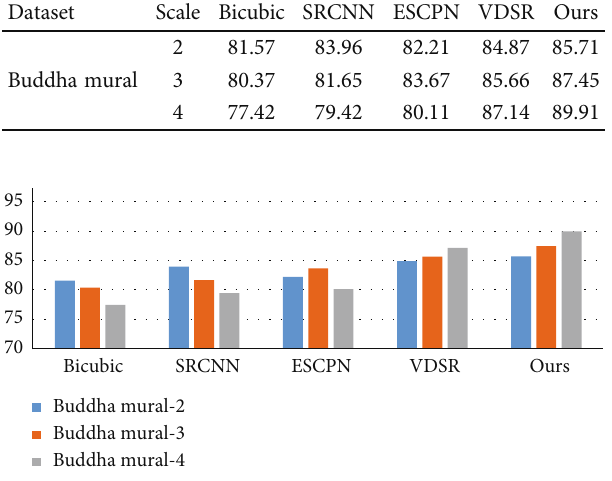
Figure 5: The classi fi cation results of the mural image test